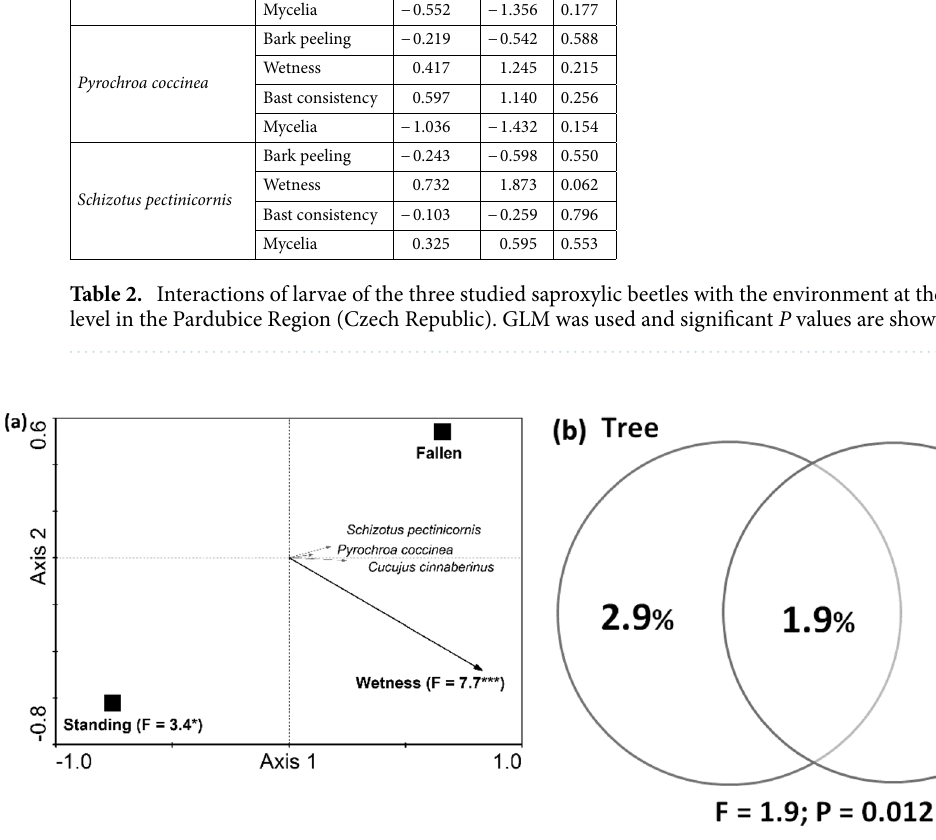
Figure 3. Responses of larvae of the three studied saproxylic beetles to the environment at the tree and microhabitat levels in the Czech Republic. ( a ) Only significant predictors are presented in the RDA plot; nonsignificant predictors were treated as covariables. * P < 0.05 and *** P < 0.001. ( b ) Venn diagram illustrating the partitioning of variance between the tree and microhabitat